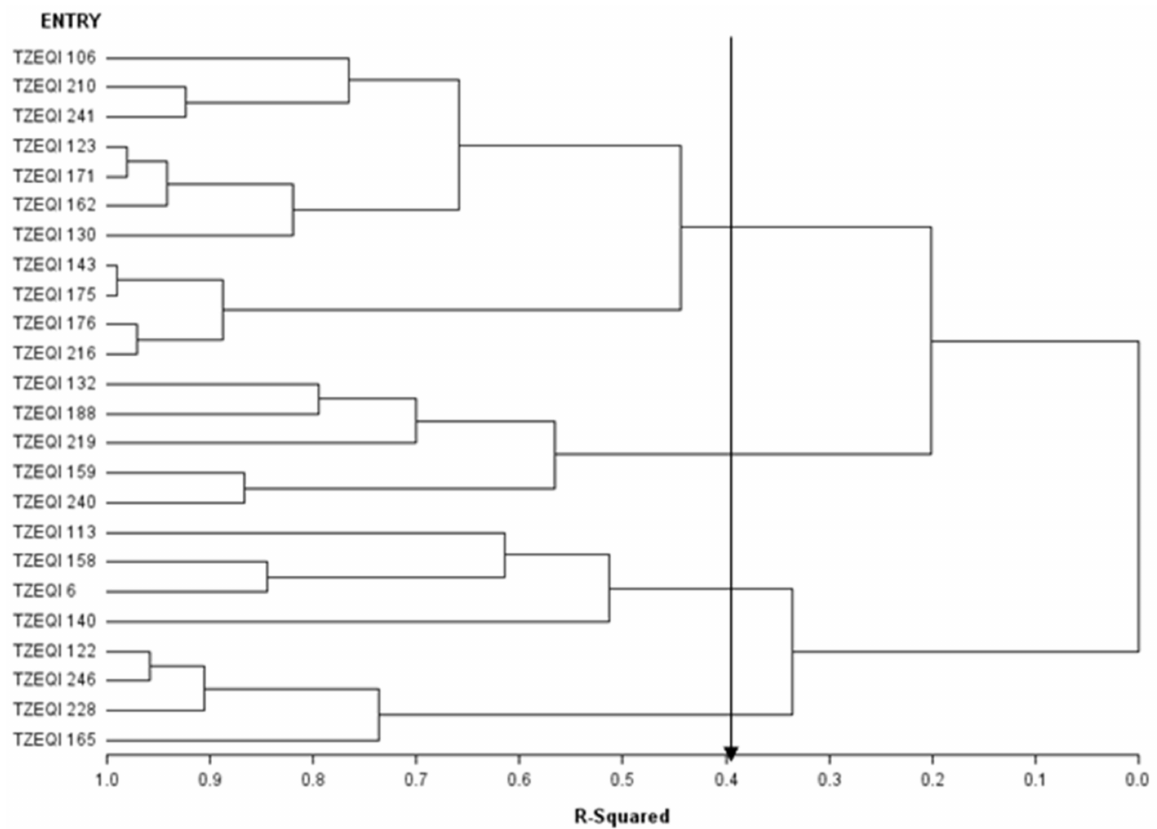
Figure 2. Heterotic grouping of the 24 early white QPM inbred